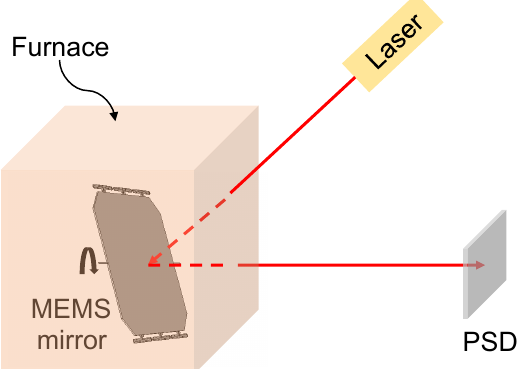
Figure 4. Schematic of the electrothermal MEMS mirror angular stability test